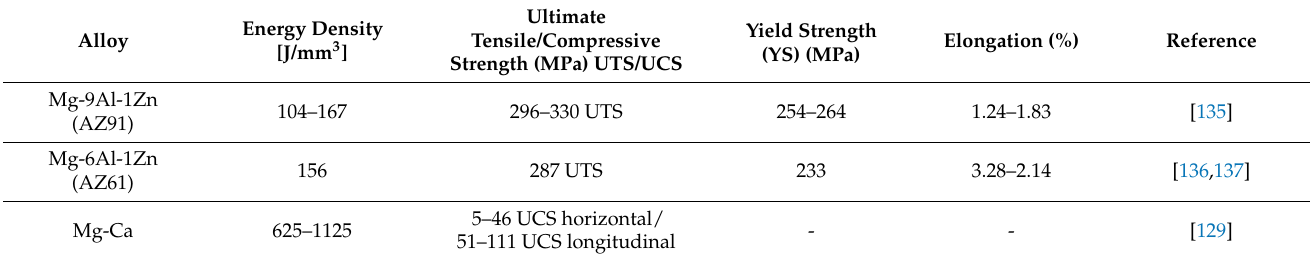
Table 6. Mechanical properties of some SLM-manufactured Mg-based